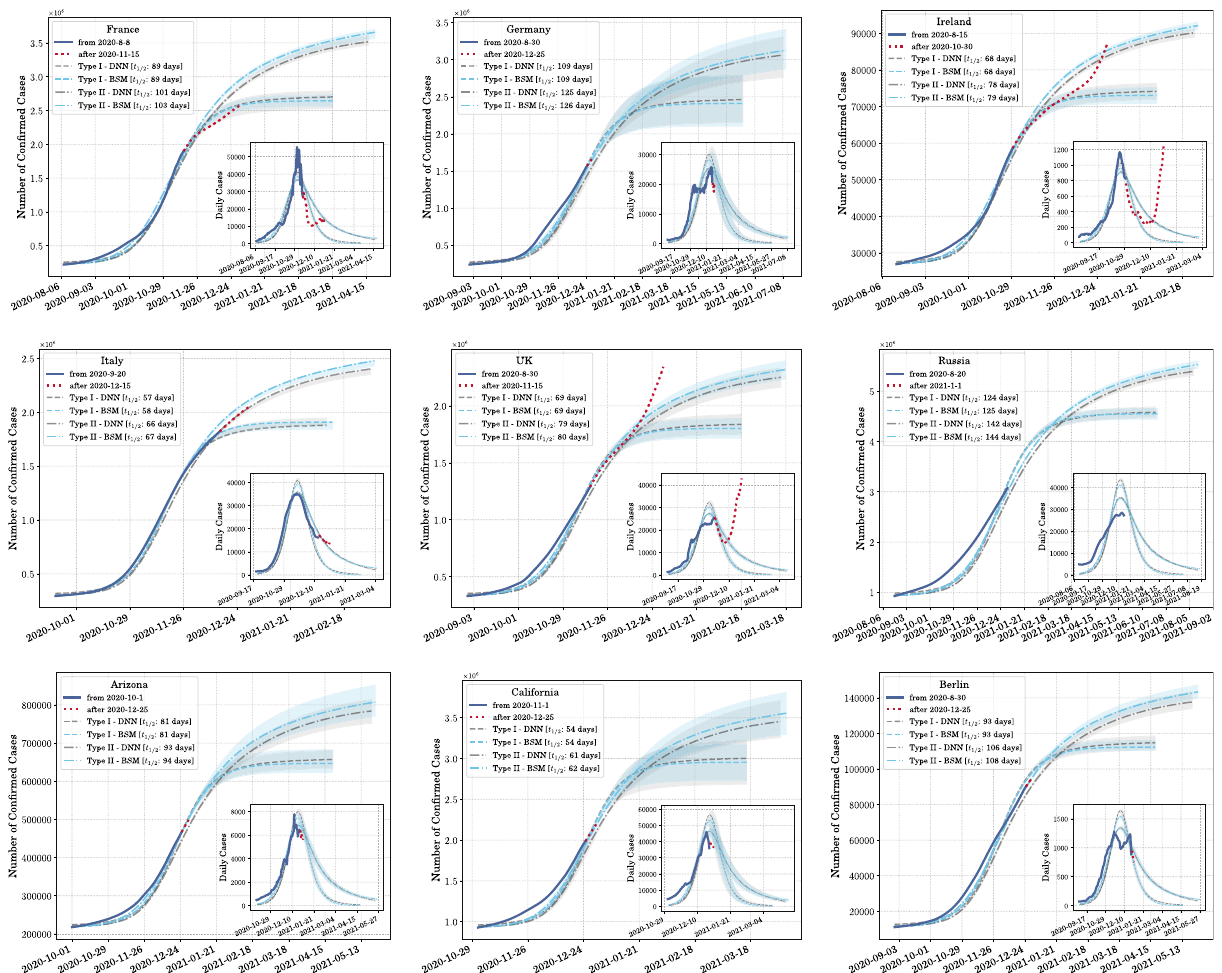
Figure 3. A display of predictability from the emergence of universality classes. We show how predictions can be made form scaling data and using knowledge gathered from phase-1 of the pandemic. Once the peak in the daily case rate is reached (or has been assumed to have reached), prediction for several weeks or months can be made. The solid dark blue lines in the insets show the data being used to find t peak , and from it, t 1 / 2 and N max . The dotted red lines in the insets are the test data which lie in the future with respect to the data used to determine the peak. The light blue lines and bands are predictions from the model-dependent fit using the Blue Sky model (BSM) to phase-1 data and the gray lines and bands are those from the model-agnostic fit using a deep neural network (DNN). The dashed lines are prediction for transmission of Type I and the dot-dashed lines are for transmission of Type II. All predictions are made till ˜ t = 2.5 or t = 2.5 t 1 / 2 starting from the beginning of the ongoing phase of disease spread. The top and middle rows show predictions for various countries while the bottom row shows predictions for two states in the USA and one in